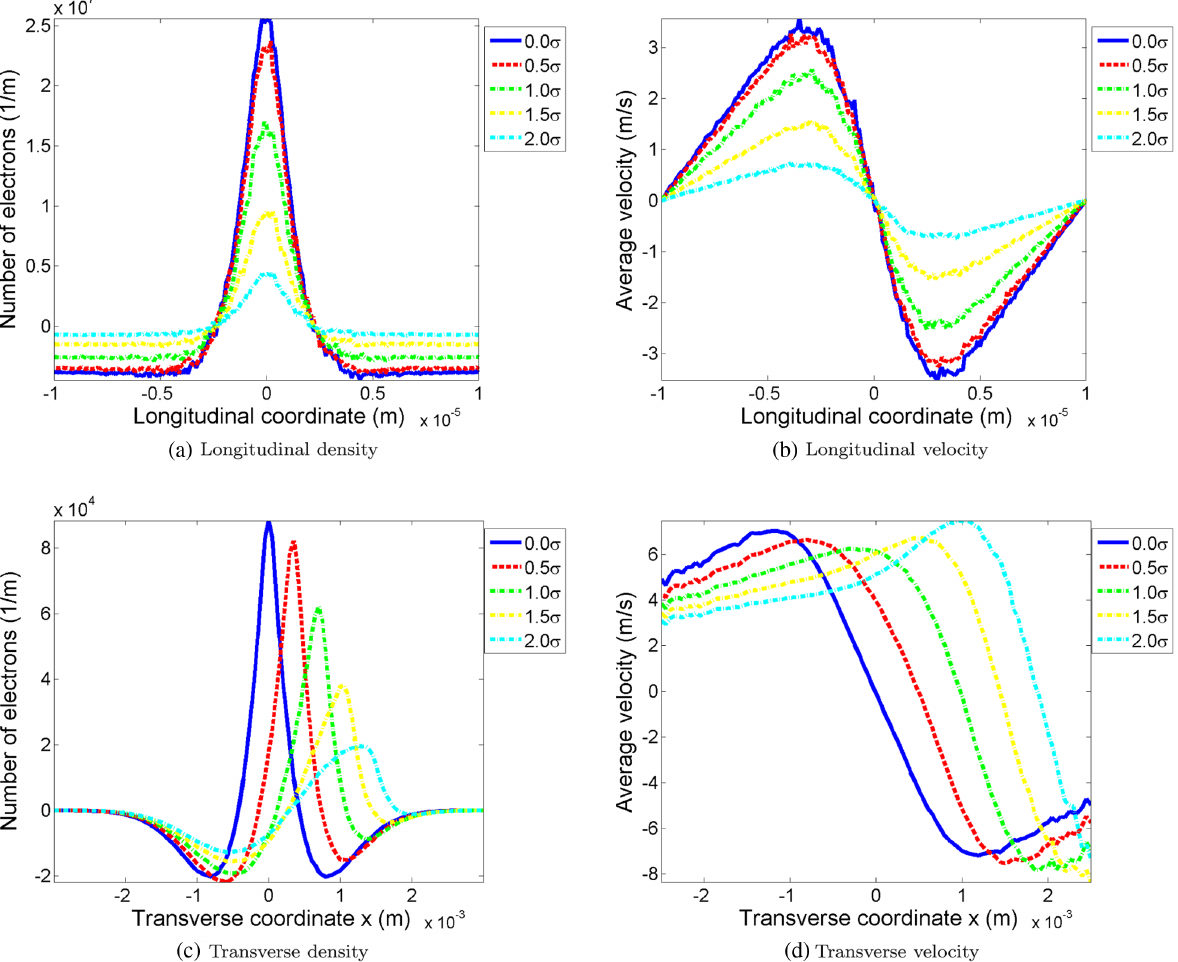
FIG. 6. Density and velocity modulation by reference energy ion with various distances off the center of the Gaussian electron beam in linear focusing field after 3m of copropagation with